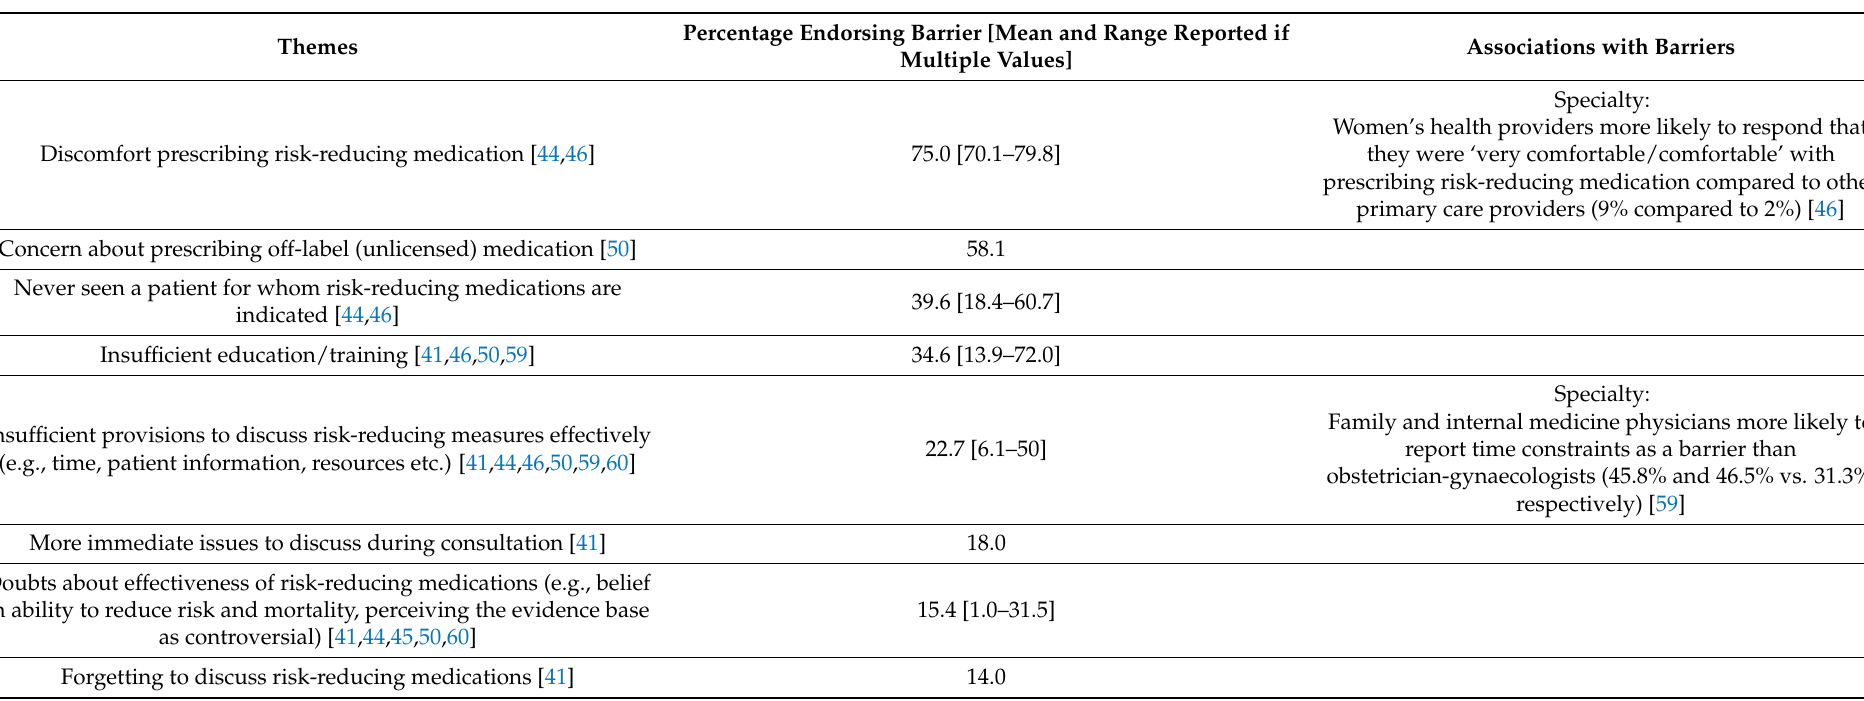
Table 6. Primary care providers’ perceptions of barriers associated with providing primary prevention